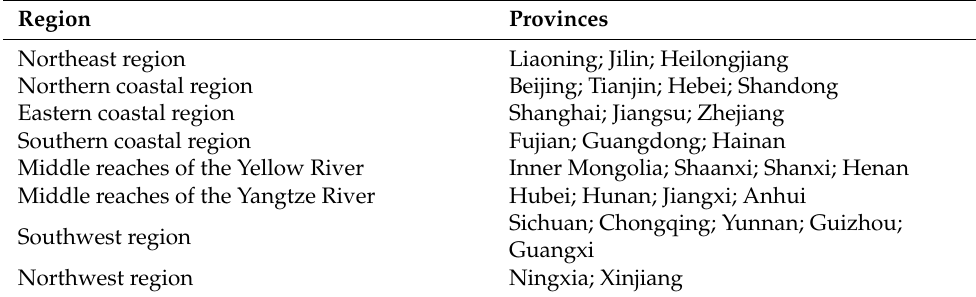
Table 8. The classification of China using the “Eight Economic Region”